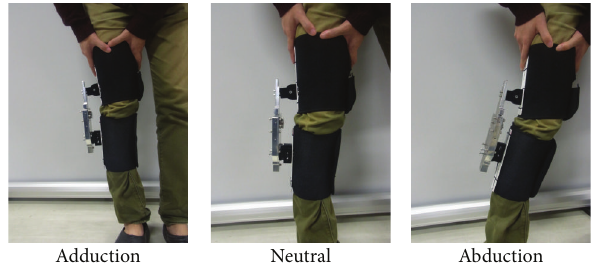
Figure 13: Installation of hinge parts and their motion.